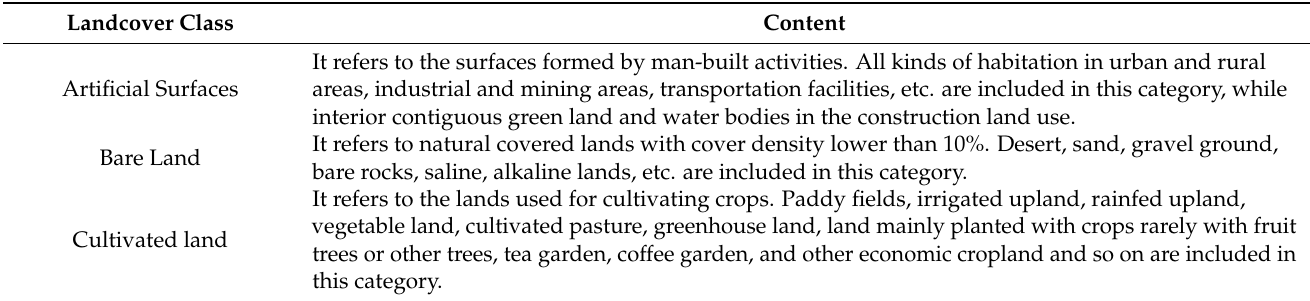
Table 1. GlobeLand30 Classification System